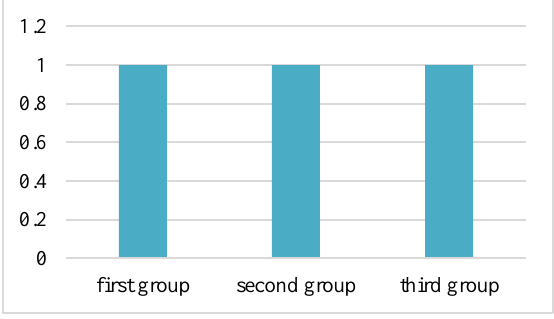
Figure 2. Neutral mode in autistic